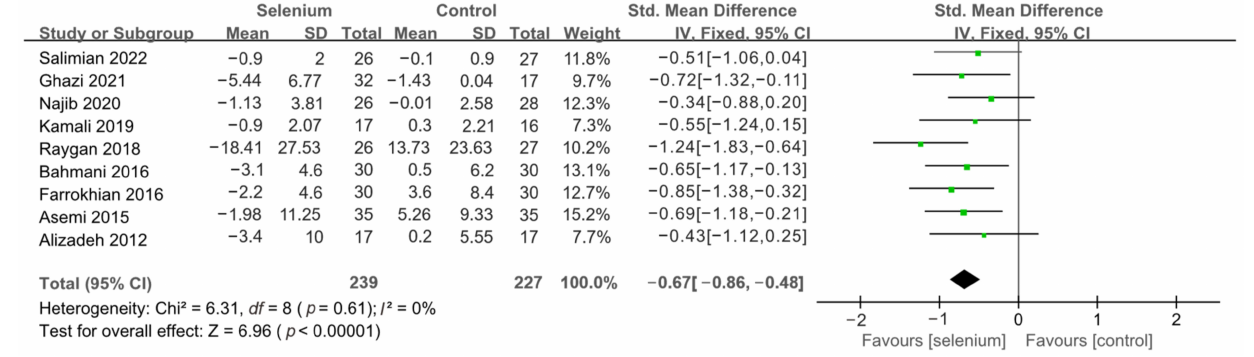
Figure 6. Forest plot of insulin levels after excluding Faghihi 2014 [30,41–47,49].